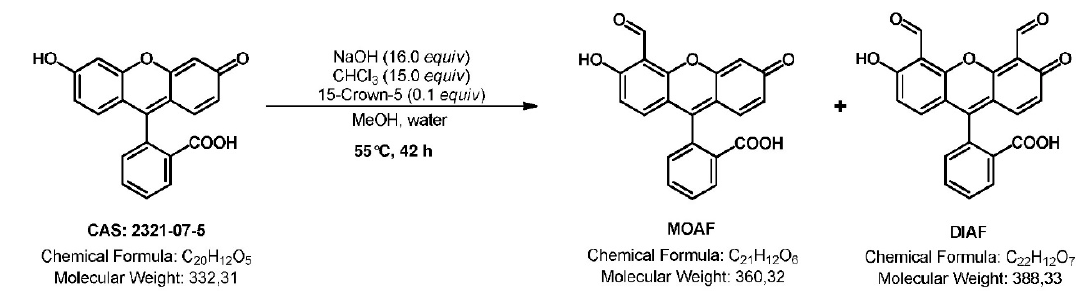
Figure 1. Reimer-Tieman formylation of